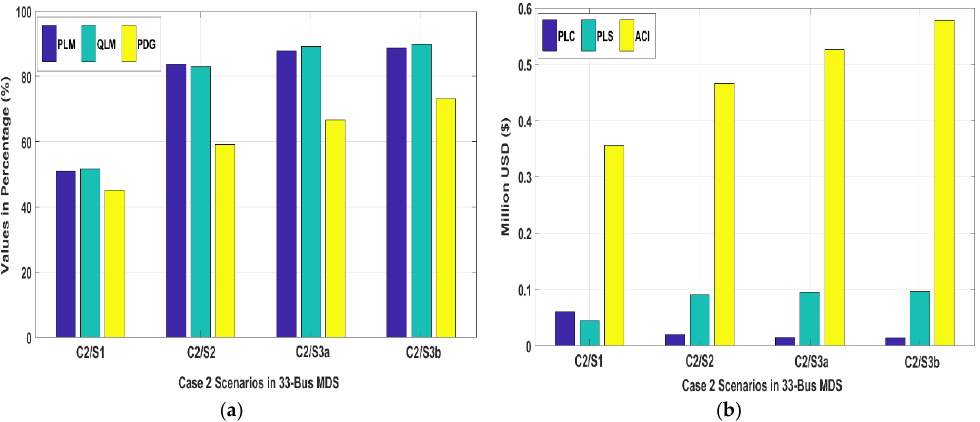
Figure 12. Case 2 Scenarios for 33-bus MDS (L_Min) ( a ) Performance evaluation in-terms of PLM,